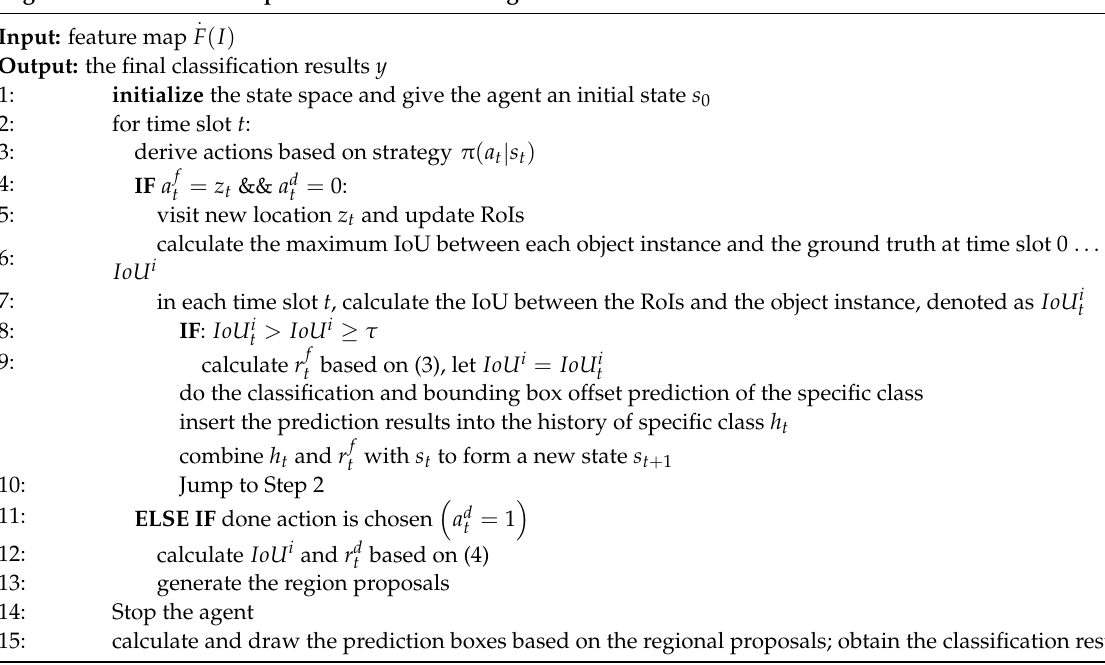
Algorithm 1 Modified deep reinforcement learning